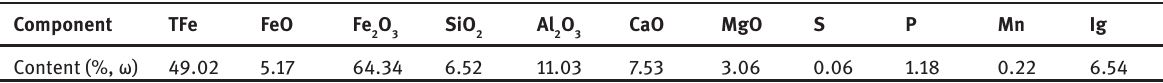
Table 1: Chemical composition of raw oolitic iron sample. Component